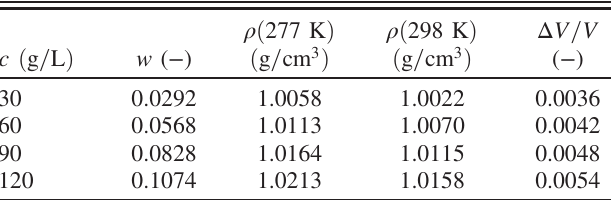
TABLE I. Relative volume change ( Δ V=V ) with change of temperature in free thermal expansion at atmospheric pressure (1 atm), based on Ref.